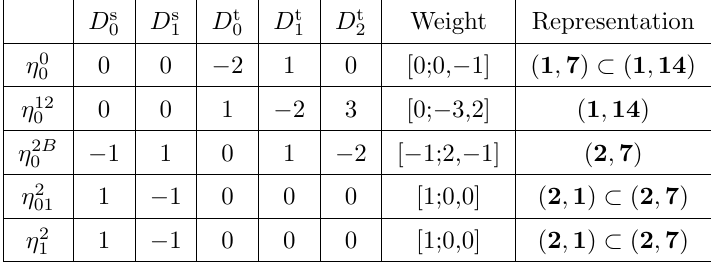
Table 8 . Weights and representations of the components of the generic curve over S \ T in Resolution IV of the SU(2) (cid:2) G 2 -model. See section 4.2 for more information on the interpretation of these representations.